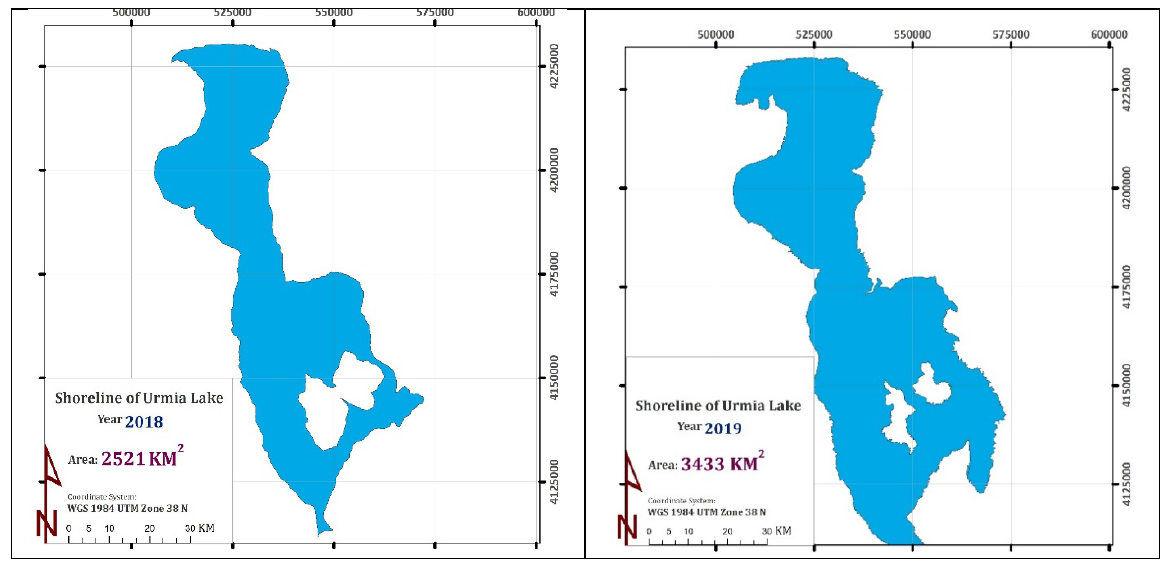
Figure 5- Shorelines and areas of Urmia Lake 2010 to 2019